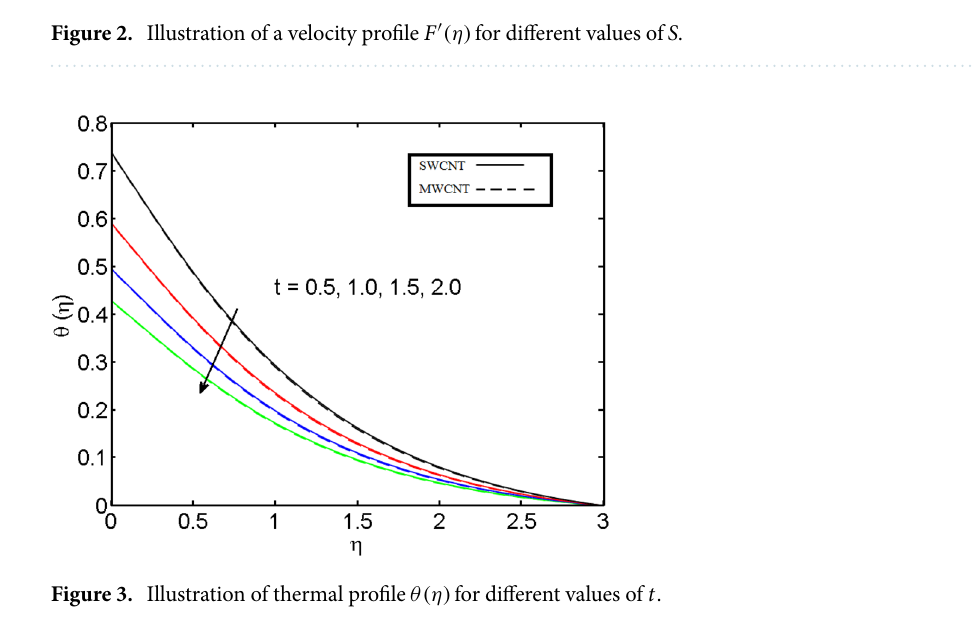
Figure 3. Illustration of thermal profile θ(η) for different values of t .